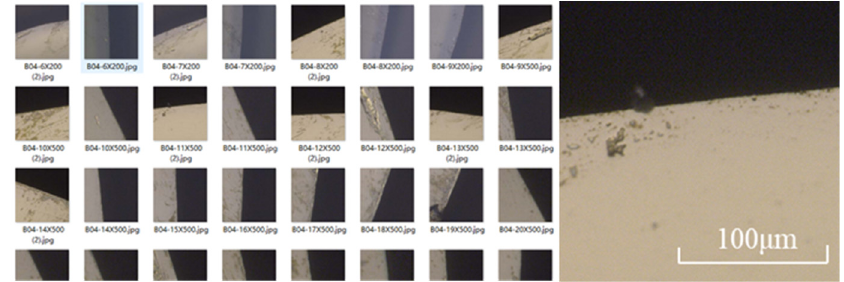
Figure 9. Image of diamond tool defect collected on ‐ machine.